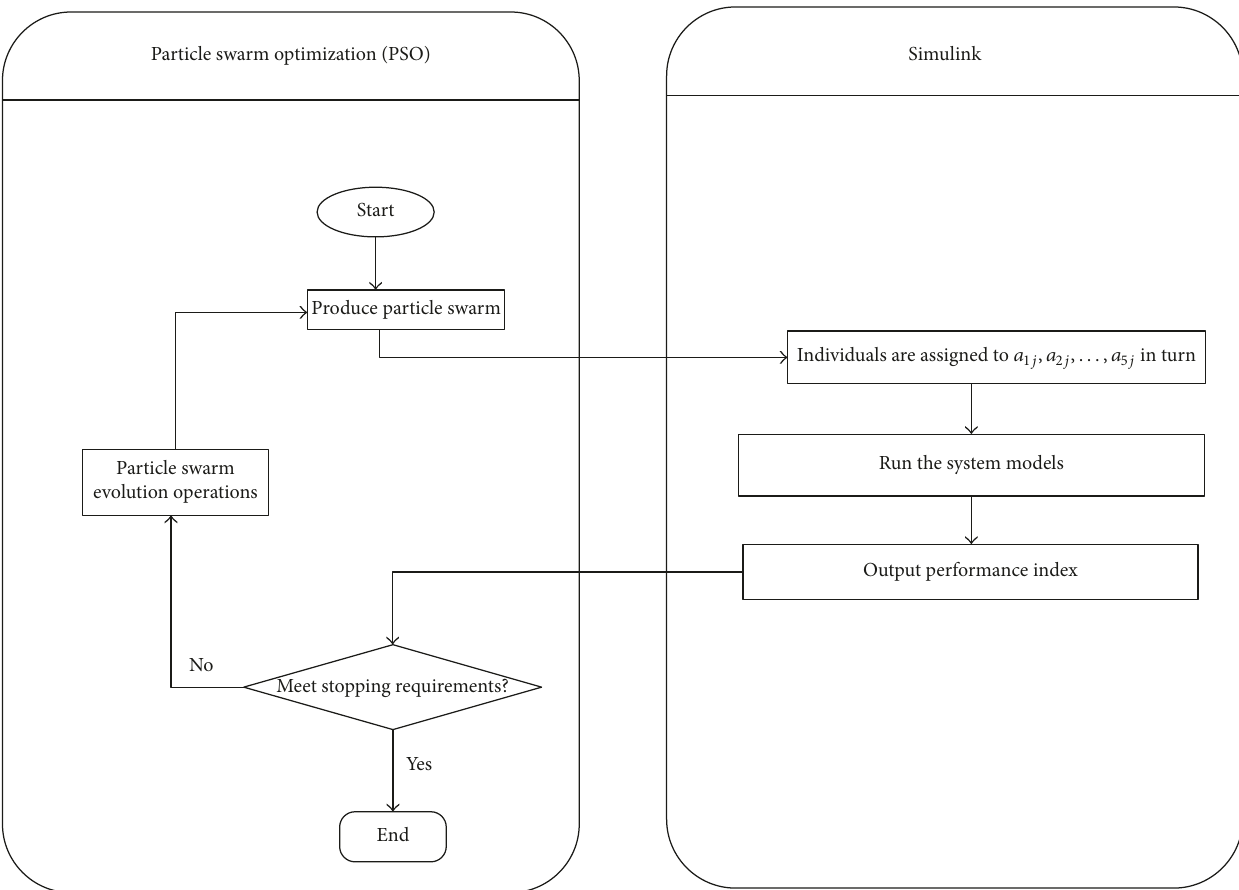
Figure 12: Flow chart of the fuzzy control optimized by